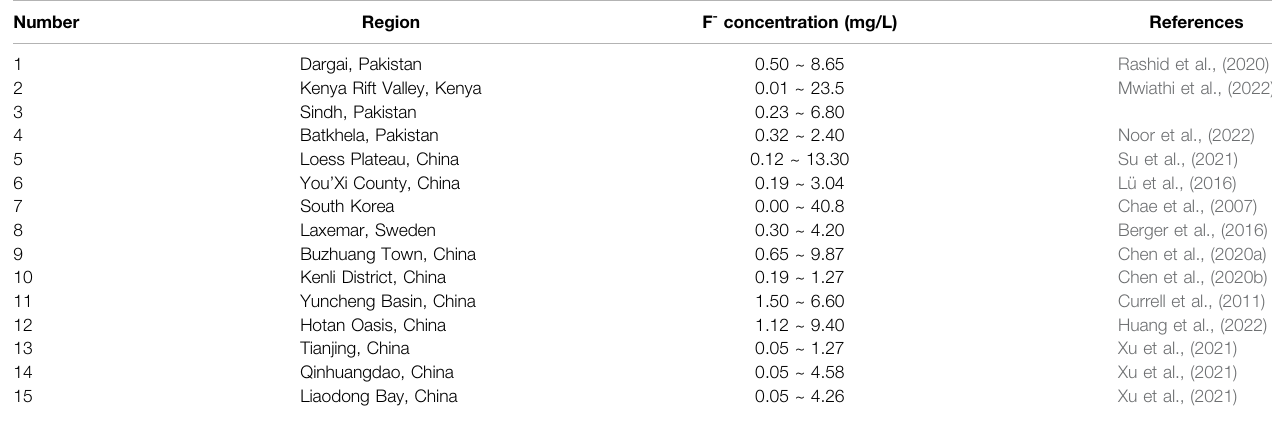
TABLE 1 | The F - concentration of groundwater in parts of the world. Number Region F - concentration